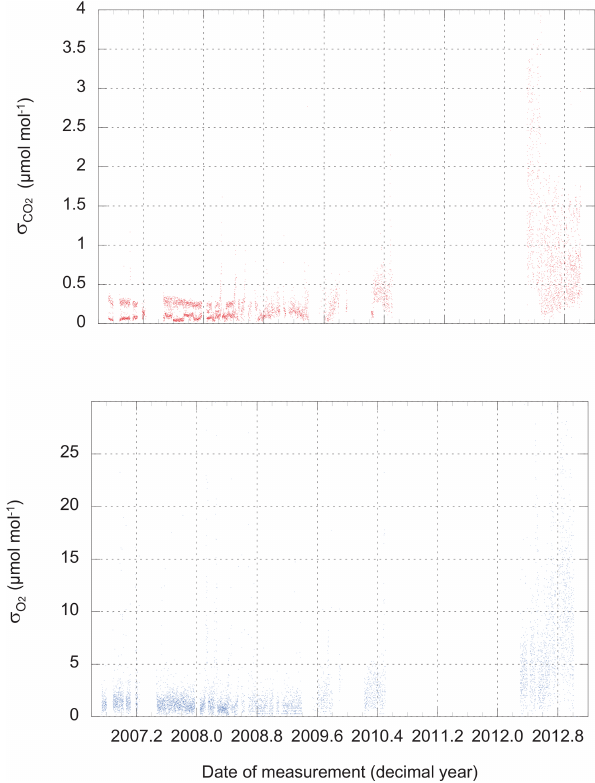
Figure 2. The scatter (standard deviation from the mean) of routine CO 2 and O 2 measurements of calibration tanks. Values plotted here apply to individual CO 2 measurements (1Hz) and single difference- of-difference O 2 values (one value every